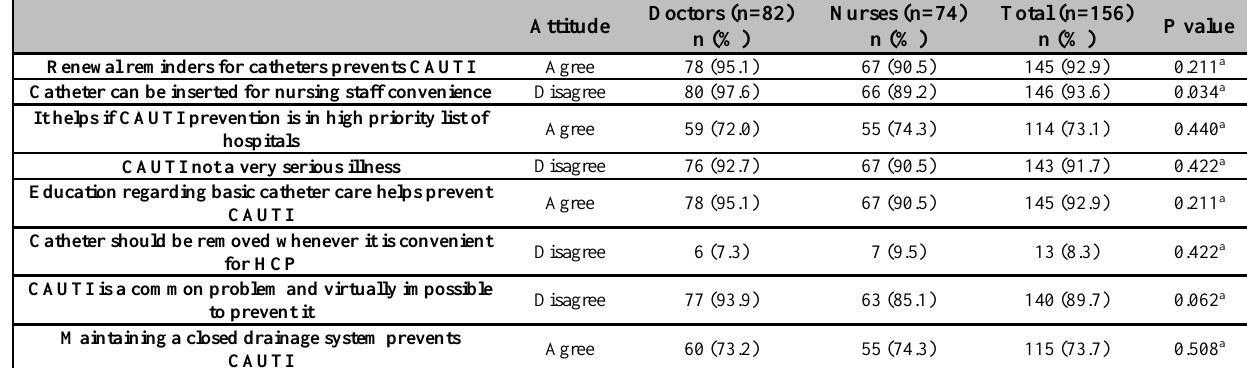
Table 5: Attitudes of doctors and nurses regarding urinary cauterization practices